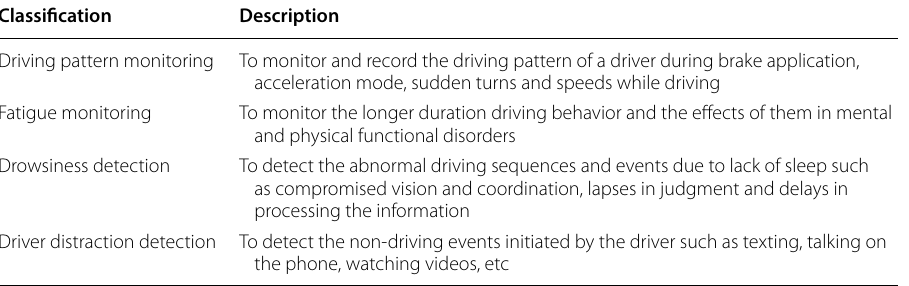
Table 4 Classification of MHYD Classification